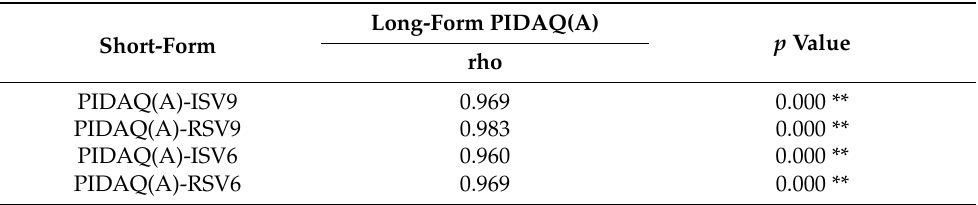
Table 8. The criterion validity: correlations between the short versions and the long version